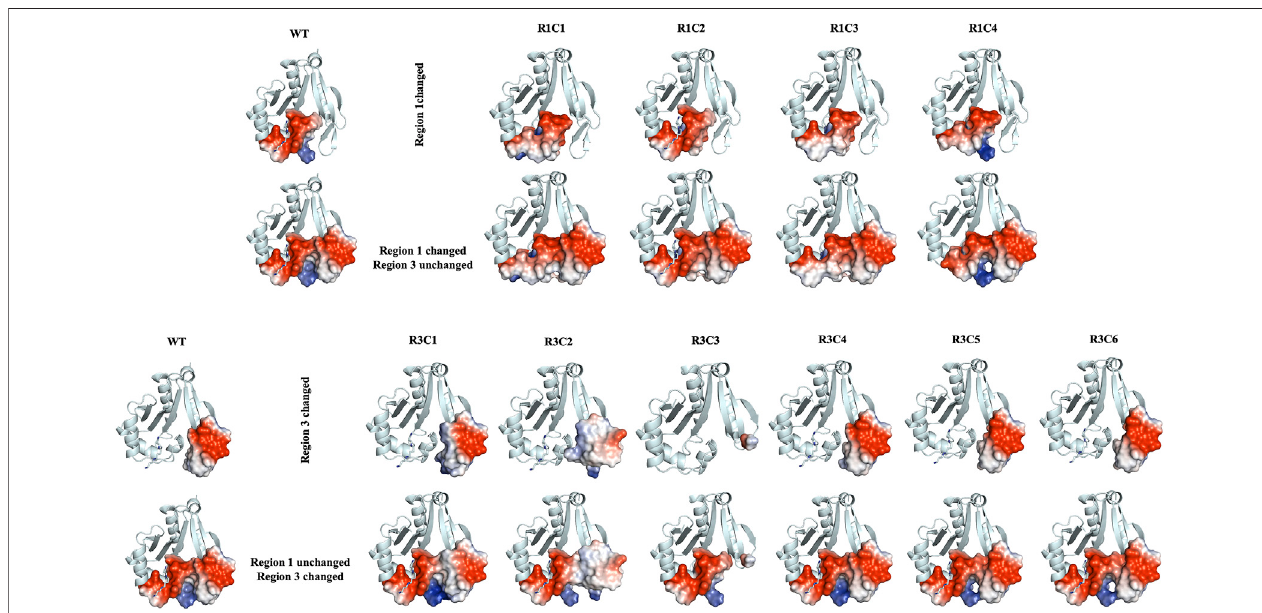
FIGURE 10 | Electrostatic surface representations for Regions 1 and 3 constructs compared to WT VcSpeG. Ribbon diagrams of homology models for each construct are shown and are based on the VcSpeG WT PDB ID: 4mi4 crystal structure with spm bound in the allosteric site. Electrostatic surfaces were calculated in Pymol for Regions 1 and 3 of each construct, where blue represents positive charge, red is negative charge and white is neutral. The upper panel of the fi gure shows constructs that were modi fi ed in Region 1, with Region 3 remaining unchanged, and the bottom panel shows constructs modi fi ed in Region 3, with Region 1 remining